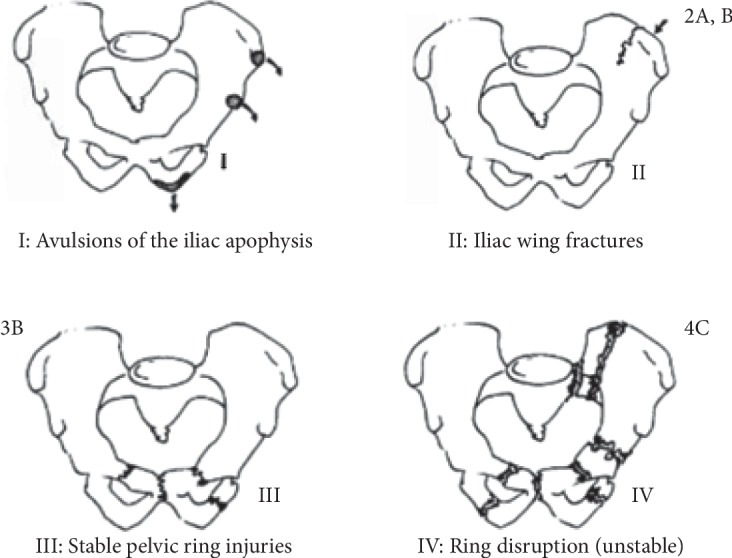
Torode and Zieg classification [6].